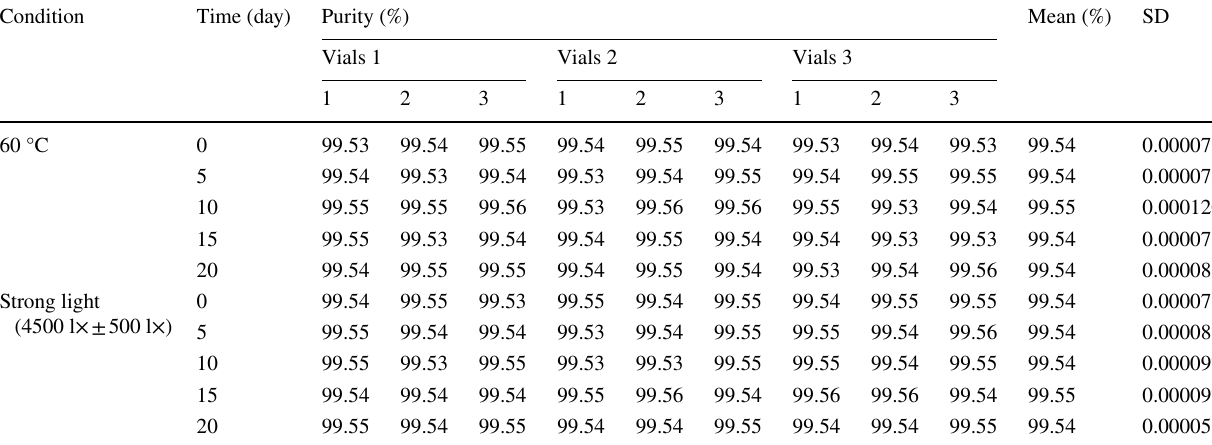
Table 3 Measurement data from the short-term stability test of Betulin Condition